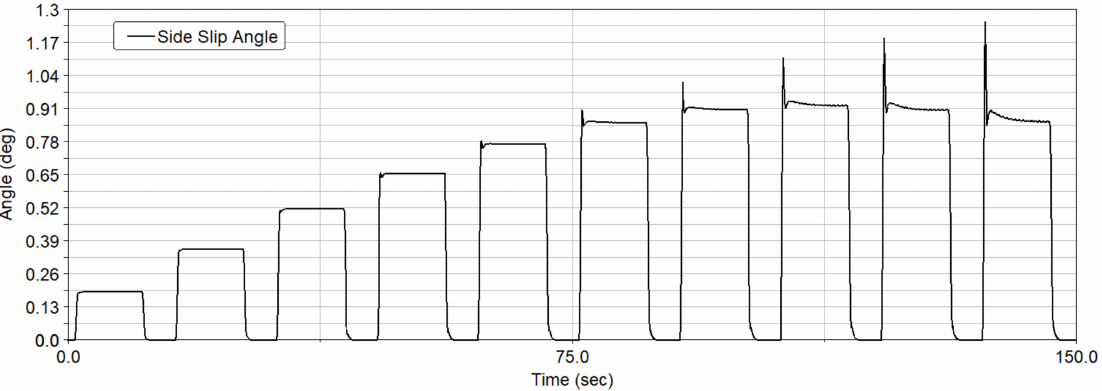
Figure 5. Skid-pad virtual test via successive step-steer maneuvers, vehicle output-slip